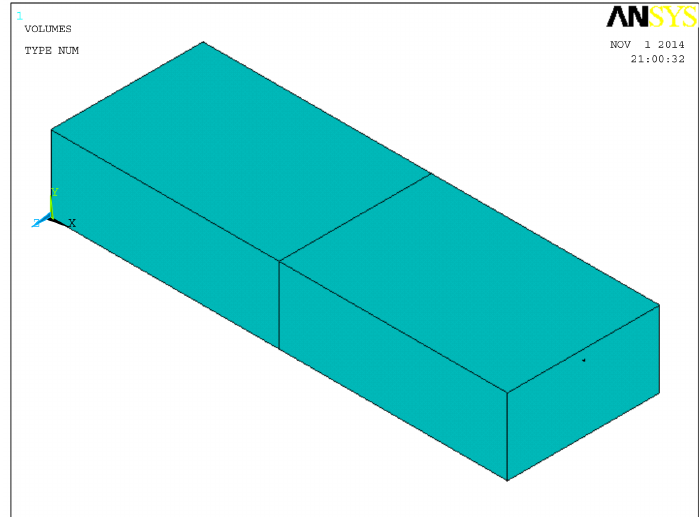
Figure 1. Physical model of buried pipeline across faults.